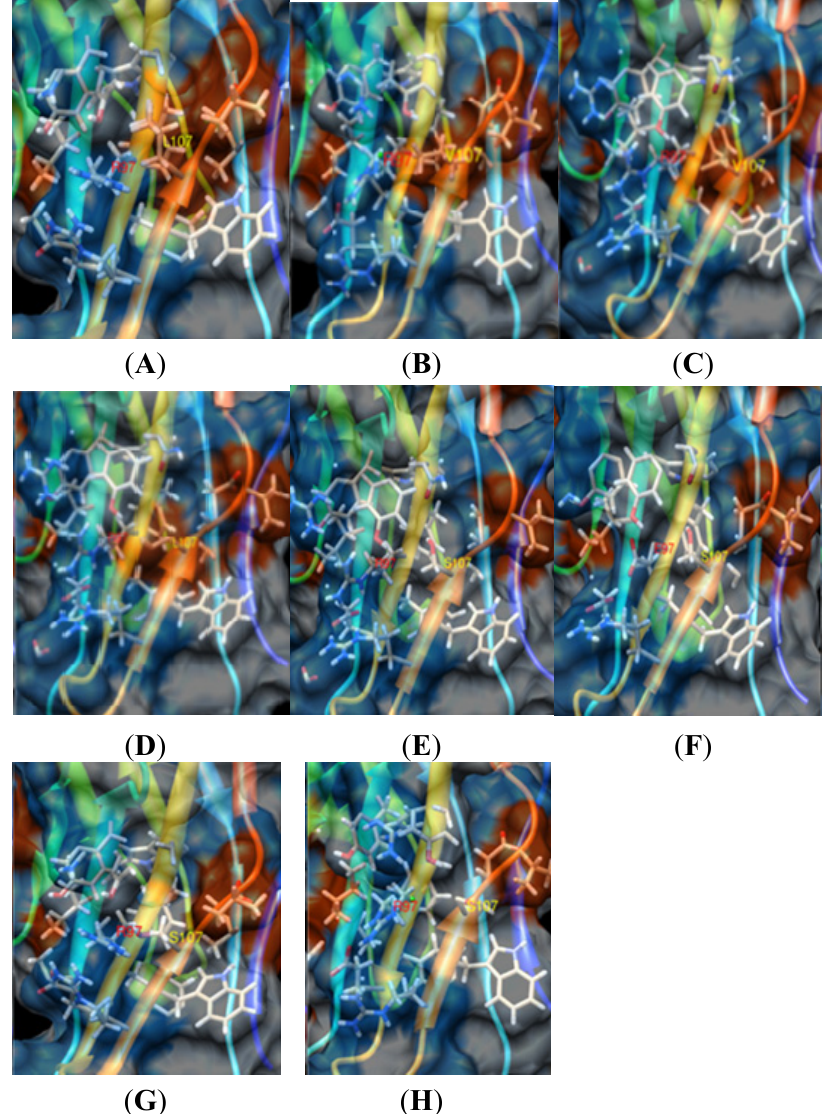
Figure 3. In the surface models of pSN, cSN and mSN binding to PRRSV, a large cavity and a hydrophilic site near the binding region were necessary for binding (blue, hydrophilic; red, hydrophobic; black, R97 and yellow, 107 (S107 in pSN, V107 in cSN and L107 in mSN)). ( A ) The cavity size of wild-type mSN 1QFP was 0 Å 3 , and with the L107 hydrophobic site, it may not bind to PRRSV sialic acid; ( B ) The cavity size of wild-type cSN was 84.5 Å 3 . With the L107 hydrophobic site, it could not bind to PRRSV sialic acid; ( C ) The cavity size of the S107V mutated pSN was 29.6 Å 3 . With the V107 hydrophobic site, it could not bind to PRRSV sialic acid; ( D ) The cavity size of S107L mutated pSN was 29.6 Å 3 . With the L107 hydrophobic site, it could not bind to PRRSV sialic acid; ( E ) The cavity size of wild-type pSN was 129.6 Å 3 as calculated online by CAST. With its S107 hydrophilic site, pSN could bind well to PRRSV sialic acid; ( F ) The cavity size of R97E mutated pSN was 142 Å 3 , and it could not bind to the electronegative PRRSV sialic acid; ( G ) The cavity size of L107S mutated mSN was 133.1 Å 3 . With the S107 hydrophobic site, it may bind to PRRSV sialic acid; and ( H ) The cavity size of V107S mutated cSN was 77.2 Å 3 . With the S107 hydrophilic site, it could bind to PRRSV sialic